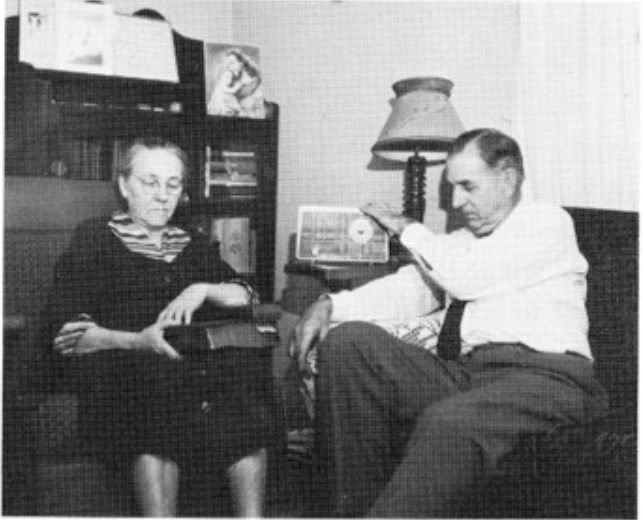
Figure 4 . Image from a pamphlet issued by the Oral Roberts Evangelistic Association. Figure 4. Image from a pamphlet issued by the Oral Roberts Evangelistic Association